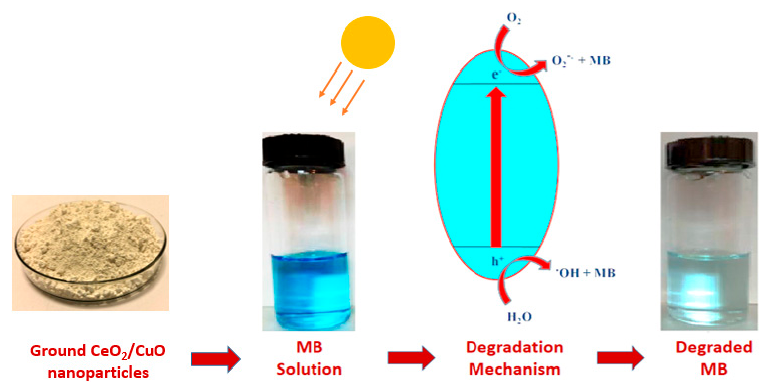
Figure 2. Photocatalytic degradation of methylene blue at of CeO 2 /CuO nanoparticles. Percentage degradation was estimated with help of Equation (1) [29].